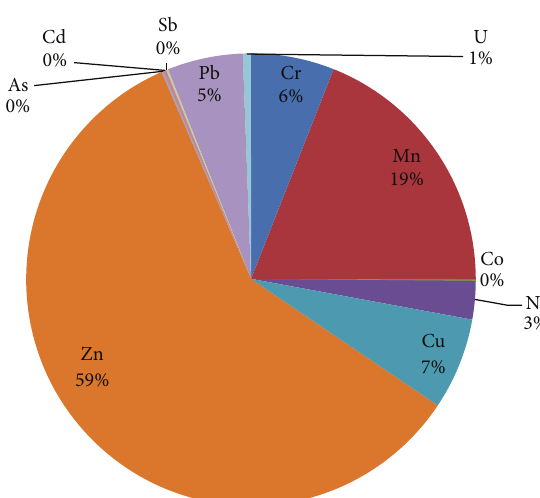
Figure6:Distributionoftracemetalsindustsamplescollectedfrom School F.